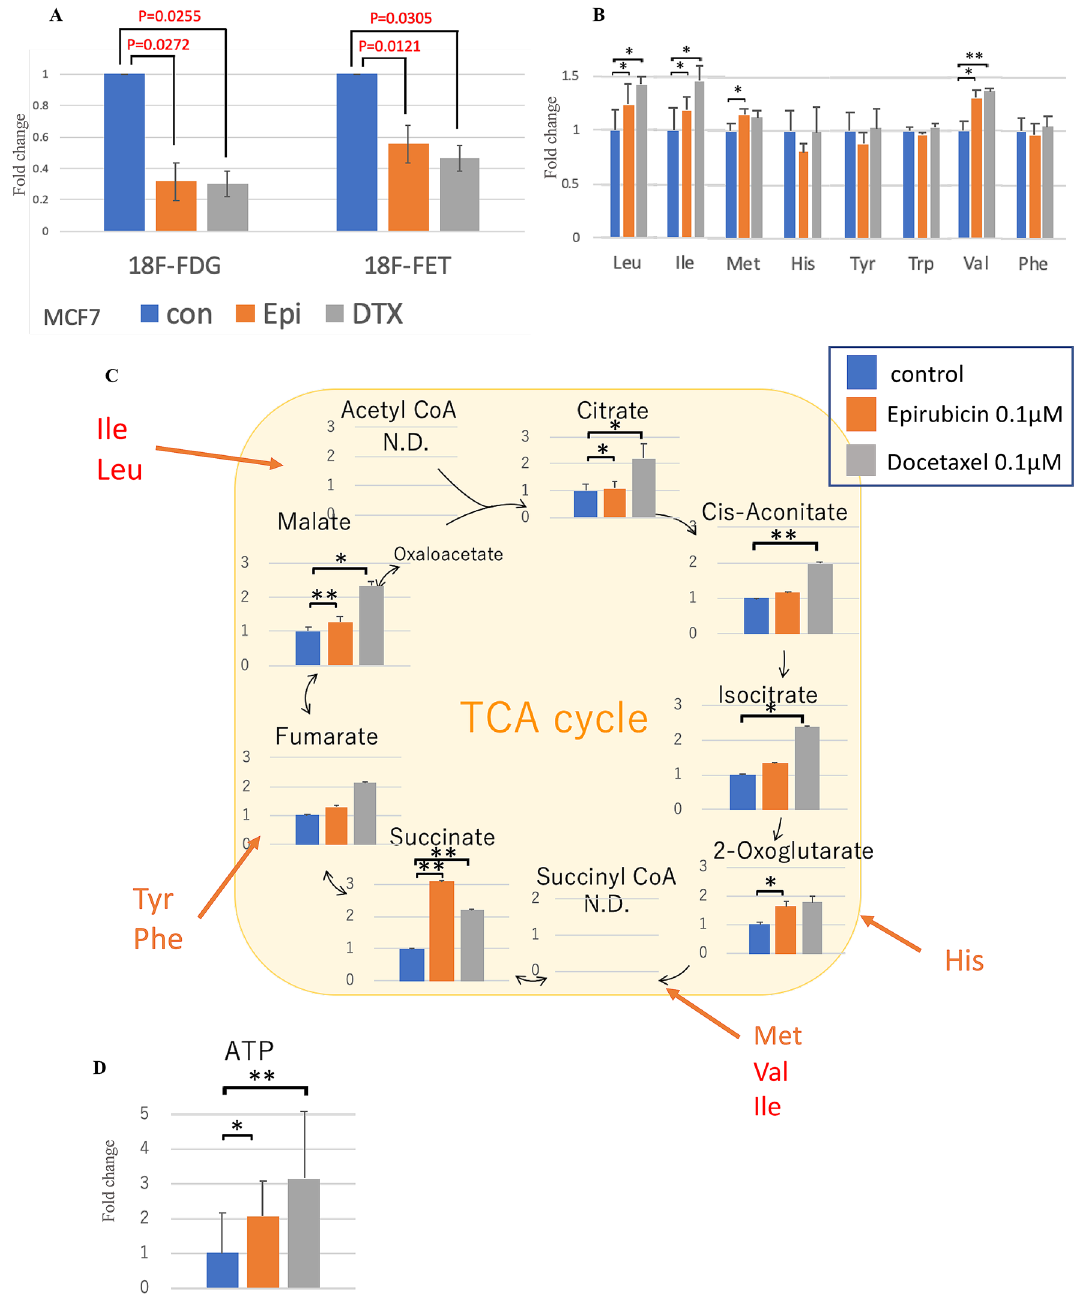
Figure 3. Change of amino acid metabolism with chemotherapy. Cellular uptake of radiotracers 18F-FDG and 18F-FET in MCF7 cells with 0.1 μM epirubicin or docetaxel for 48 h ( A ). Metabolome analysis of MCF7 cells with 0.1 μM epirubicin or docetaxel for 48 h. These are amino acid levels uptake via LAT1 with control set to 1 ( B ), intermediates of TCA cycle (fold change) ( C ) and ATP levels (fold change) ( D ). bars, N.D., the metabolite concentration was below the detection limit of the analysis. All the P values were evaluated by the Student t-test. * P < 0.05; ** P < 0.01; *** P <